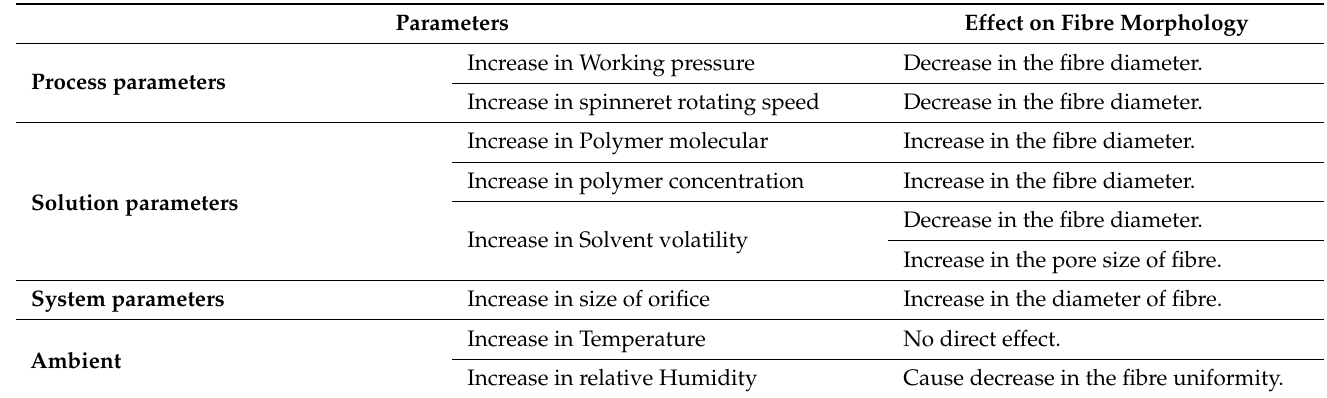
Table 10. Factors affecting the pressurised gyration process [173].